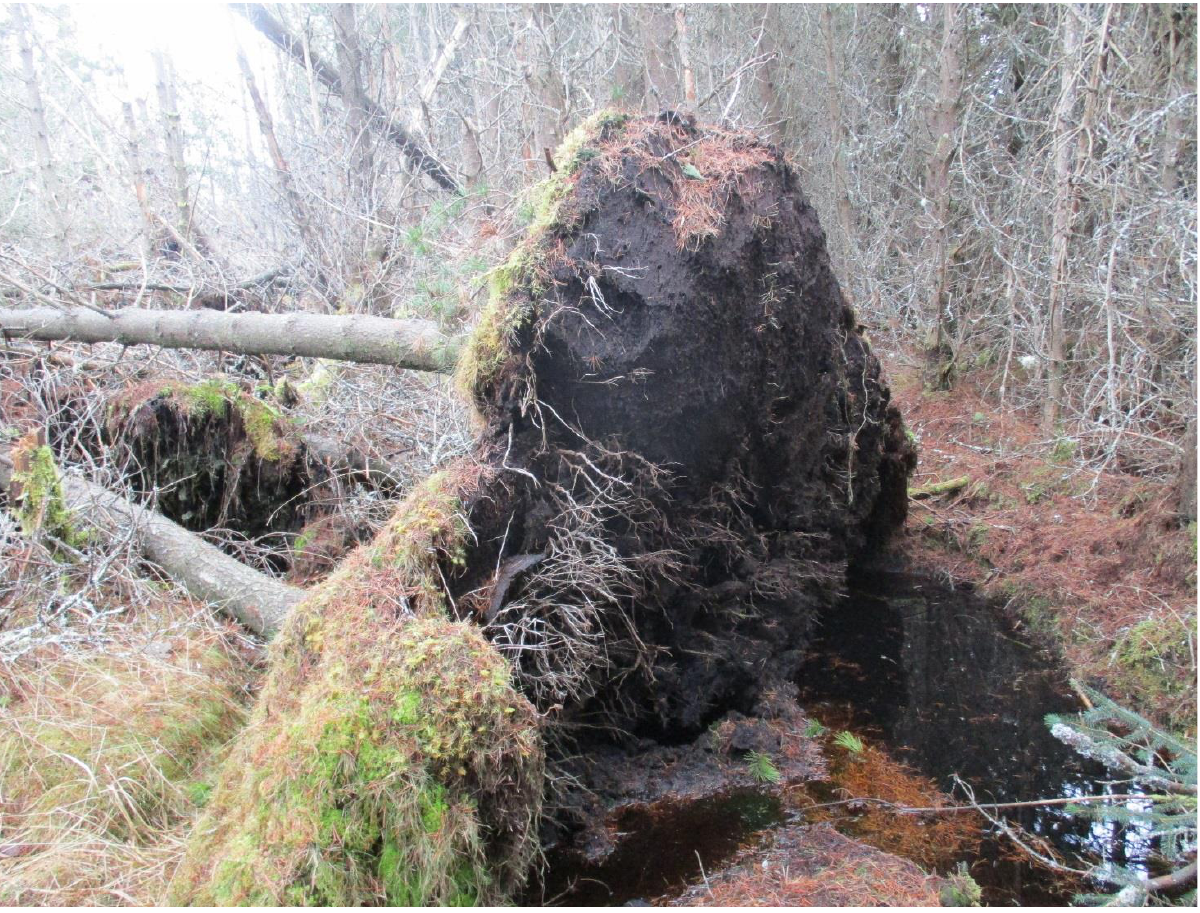
Figure 4. A wind-thrown lodgepole pine with exposed root plate at Bad a’Cheo, Rumster Forest,